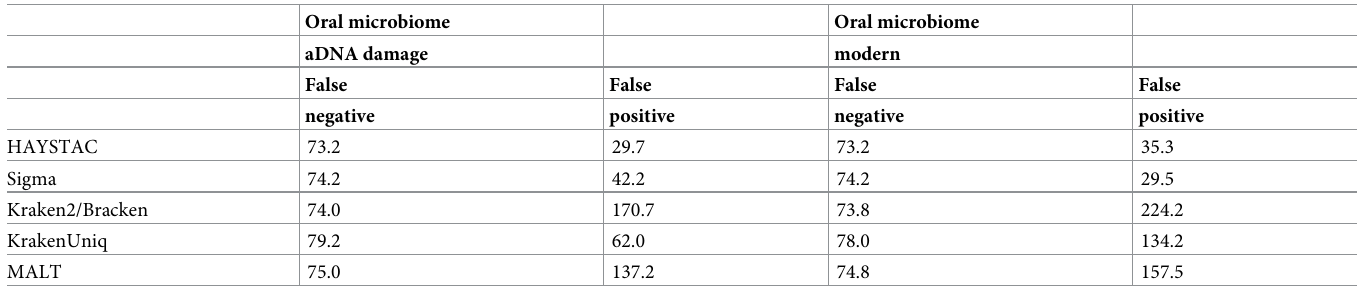
Table 2. False negative and false positive species counts in the ancient and modern Oral Microbiome datasets. Oral